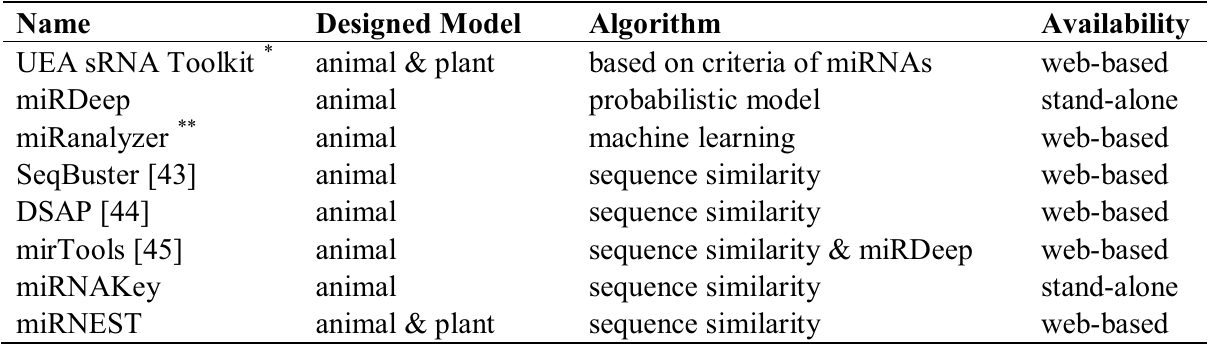
Table 1. Tools for analyzing deeply sequenced small RNA